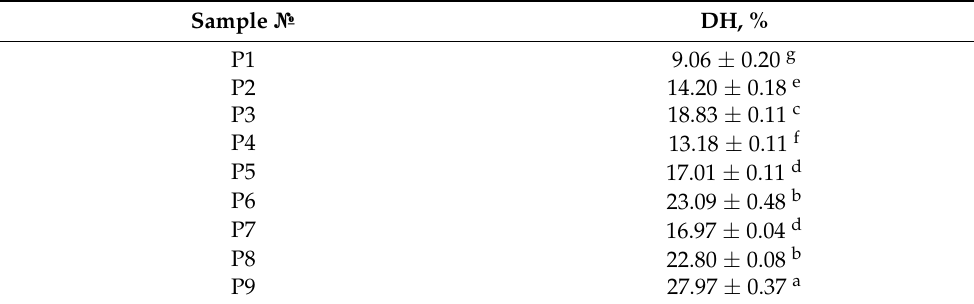
Table 2. Degree of hydrolysis of lupin protein hydrolysates.